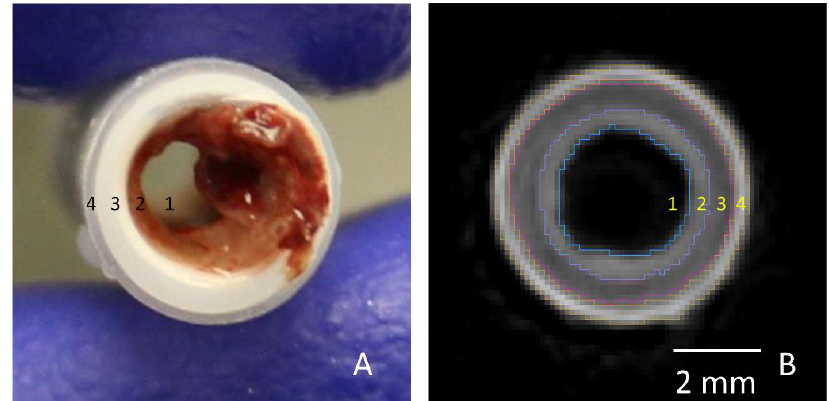
Figure 3. Cross-sectional images of two different collagen-coated ePTFE (ID = 4 mm) samples including all four labeled materials: the lumen (1), the thrombus (2), collagen-coated ePTFE biomaterial (3), and heat shrink tubing (4). Image taken after fixation is shown on the left ( A ) and a cross-section from the materials segmentation in Amira is shown on the right ( B ). Scale bar = 2 mm.